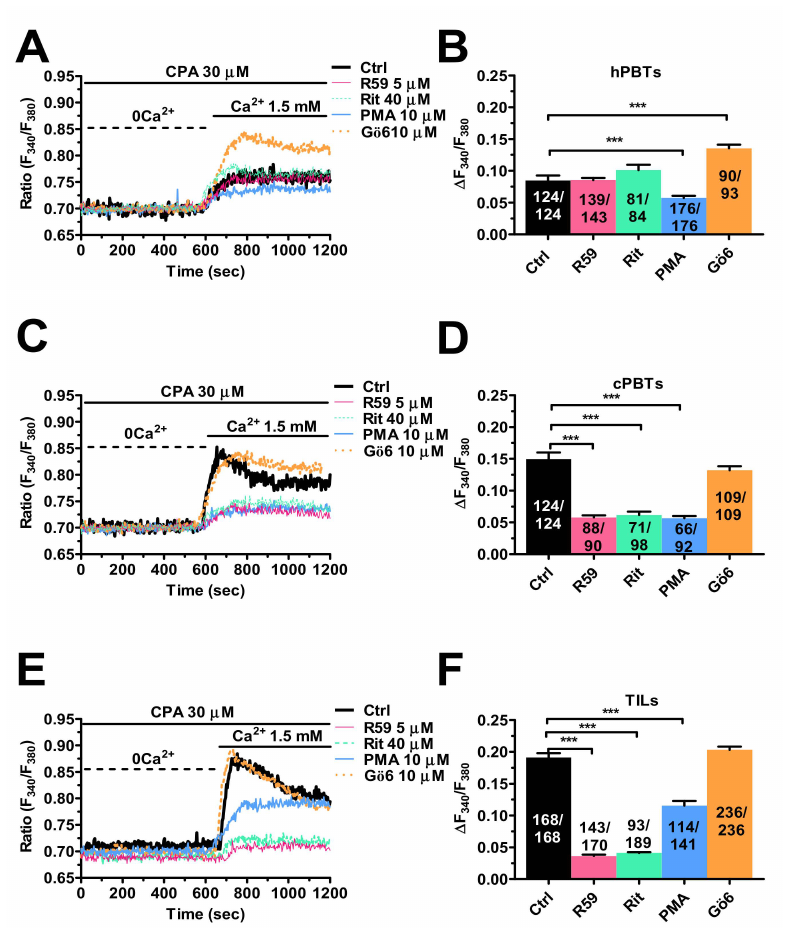
Figure 5. DGK regulates SOCE amplitude in TILs. ( A ) SOCE was activated by challenging hPBTs with CPA (30 µ M) for 20 min under 0Ca 2+ conditions (not shown) followed by restitution of extracellular Ca 2+ to the perfusate (1.5 mM). SOCE was measured in the absence (Ctrl) and in the presence of the following drugs: ritanserin (40 µ M, 10 min; Rit) or R59949 (5 µ M, 10 min; R59), which